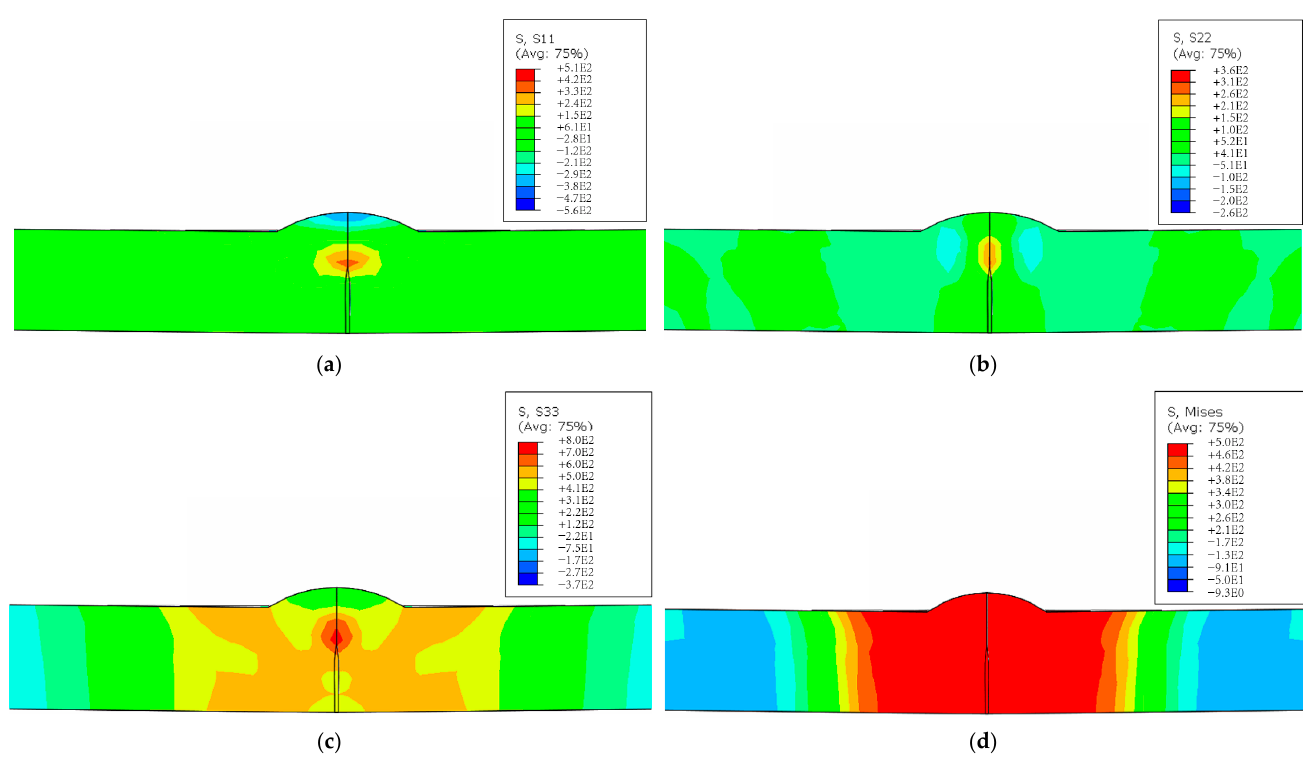
Figure 13. Simulated residual stress components in the weldment: ( a ) transverse stress, ( b ) longitu- dinal stress, ( c ) normal stress, and ( d ) von Mises equivalent residual stress.